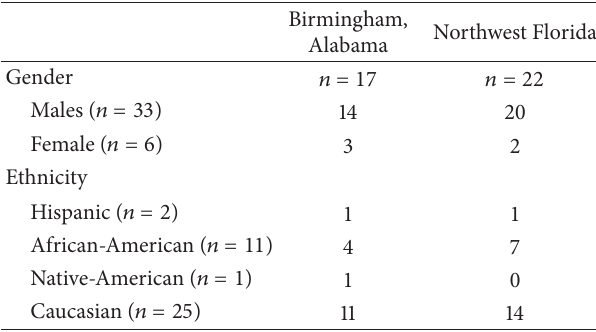
Table 1: Descriptive information for gender and ethnicity of homeless veterans by location ( 𝑁 = 39